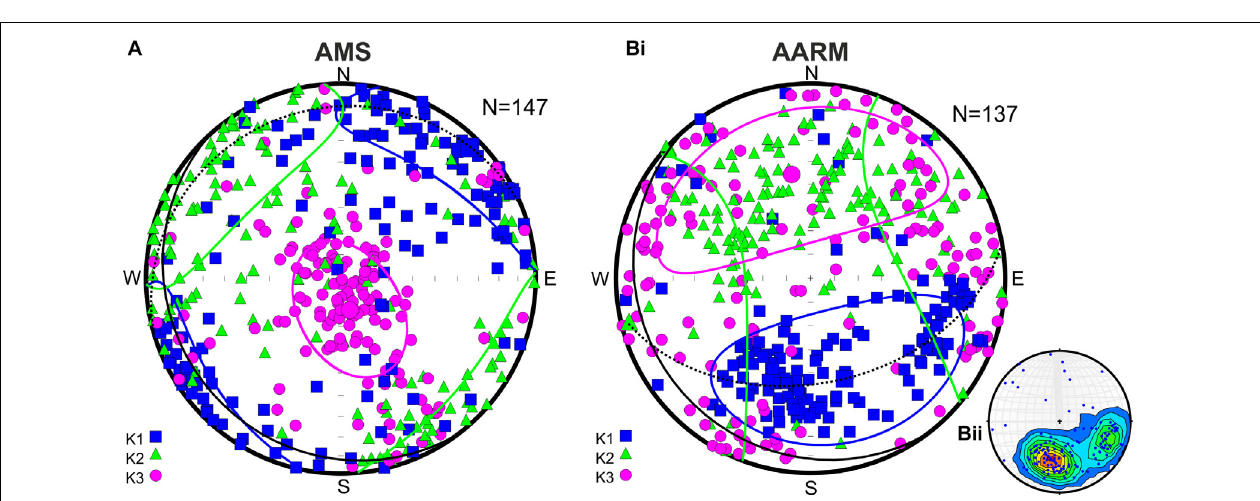
tensors (shown mostly by variations in the mean shape, see Figure 7Av ) varies across the sill thickness in an irregular and oscillatory